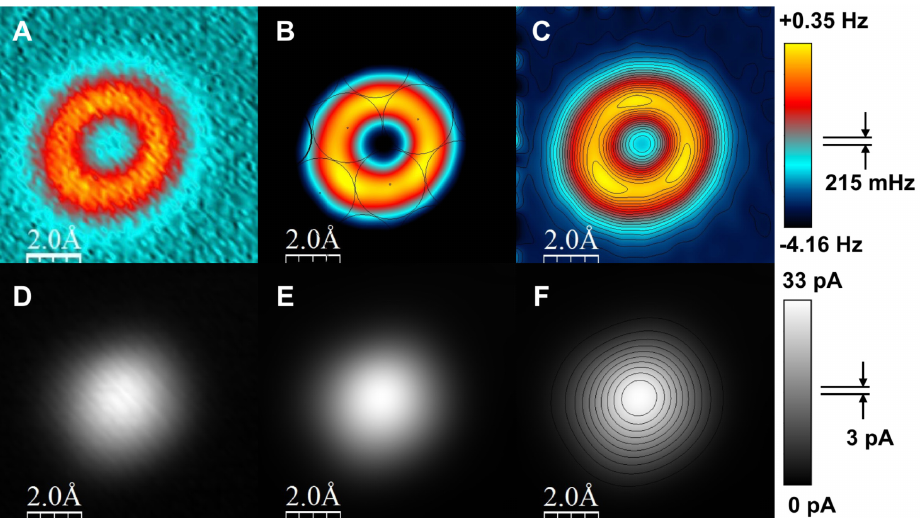
Figure 24. Experimental constant-height images of a Fe adatom on Cu(111) imaged with a CO-terminated tip. The data directly shows the experimental signal, i.e., the frequency shift rather than the forces that are computed from the frequency shift and shown in Figure 2 and Figure S4 from [71]. ( A – C ) shows the frequency shift channel in the top row and the ( D – F ) simultaneously recorded current channel in the bottom row. For both rows, the left column shows raw data, the images in the central and right column are filtered (re-dimensioned to 512 × 512 pixels and Gauss-filtered with a 32 pixels width). Parameters were qPlus sensor with f 0 = 20430Hz, k = 1800N/m, A = 25pm, Q = 182750; V bias = 100 µ V, acquisition time 50s, image size 1nm 2 and 64 × 64 pixels, scanning speed 2.56nm/s. The black circles in ( B ) indicate the surface layer of the Cu(111) plane. The Fe adatom sits on an fcc site, the three local maxima in the repulsive ring are located over hollow sites in agreement with DFT calculations. Vertical scale ranges from − 3 Hz to +0.35 Hz. In ( C ), the same data as in ( B ) is shown with contour lines and a slightly changed vertical scale ranging from − 4.16 Hz to +0.35 Hz. We note that not all CO-terminated tips allow getting close enough to resolve the three local maxima on the repulsive ring. From our experience, it is best to use relatively sharp tips that show a small vdW background. We speculate that for blunt tips, the vdW interaction between the adatom and the tip is so large that these vdW forces lead to lateral manipulation of the Fe adatom at the close distance that is required to resolve the three local maxima. While we have observed Fe adatom data that shows these three bumps with about a dozen different tips, the data shown here is of a high symmetry, showing that the CO-terminated tip was nearly perfectly vertical (for a different case, see Figure S6 in [71]). Adapted with permission by American Association for the Advancement of Science from Figure S5 in